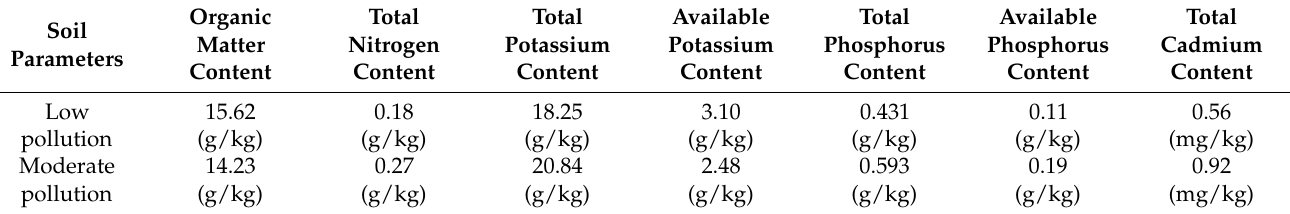
Table 1. Basic soil properties used in the